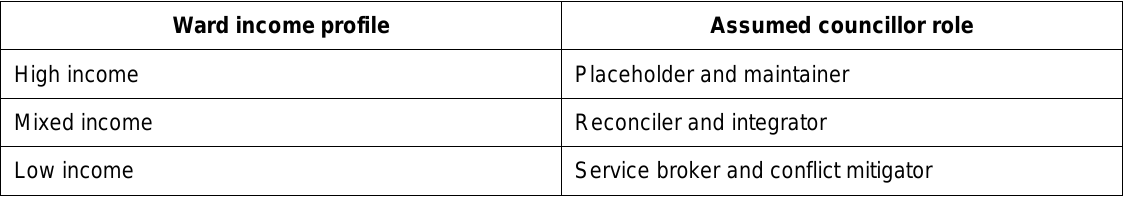
Table 1: Heuristic model of ward councillor